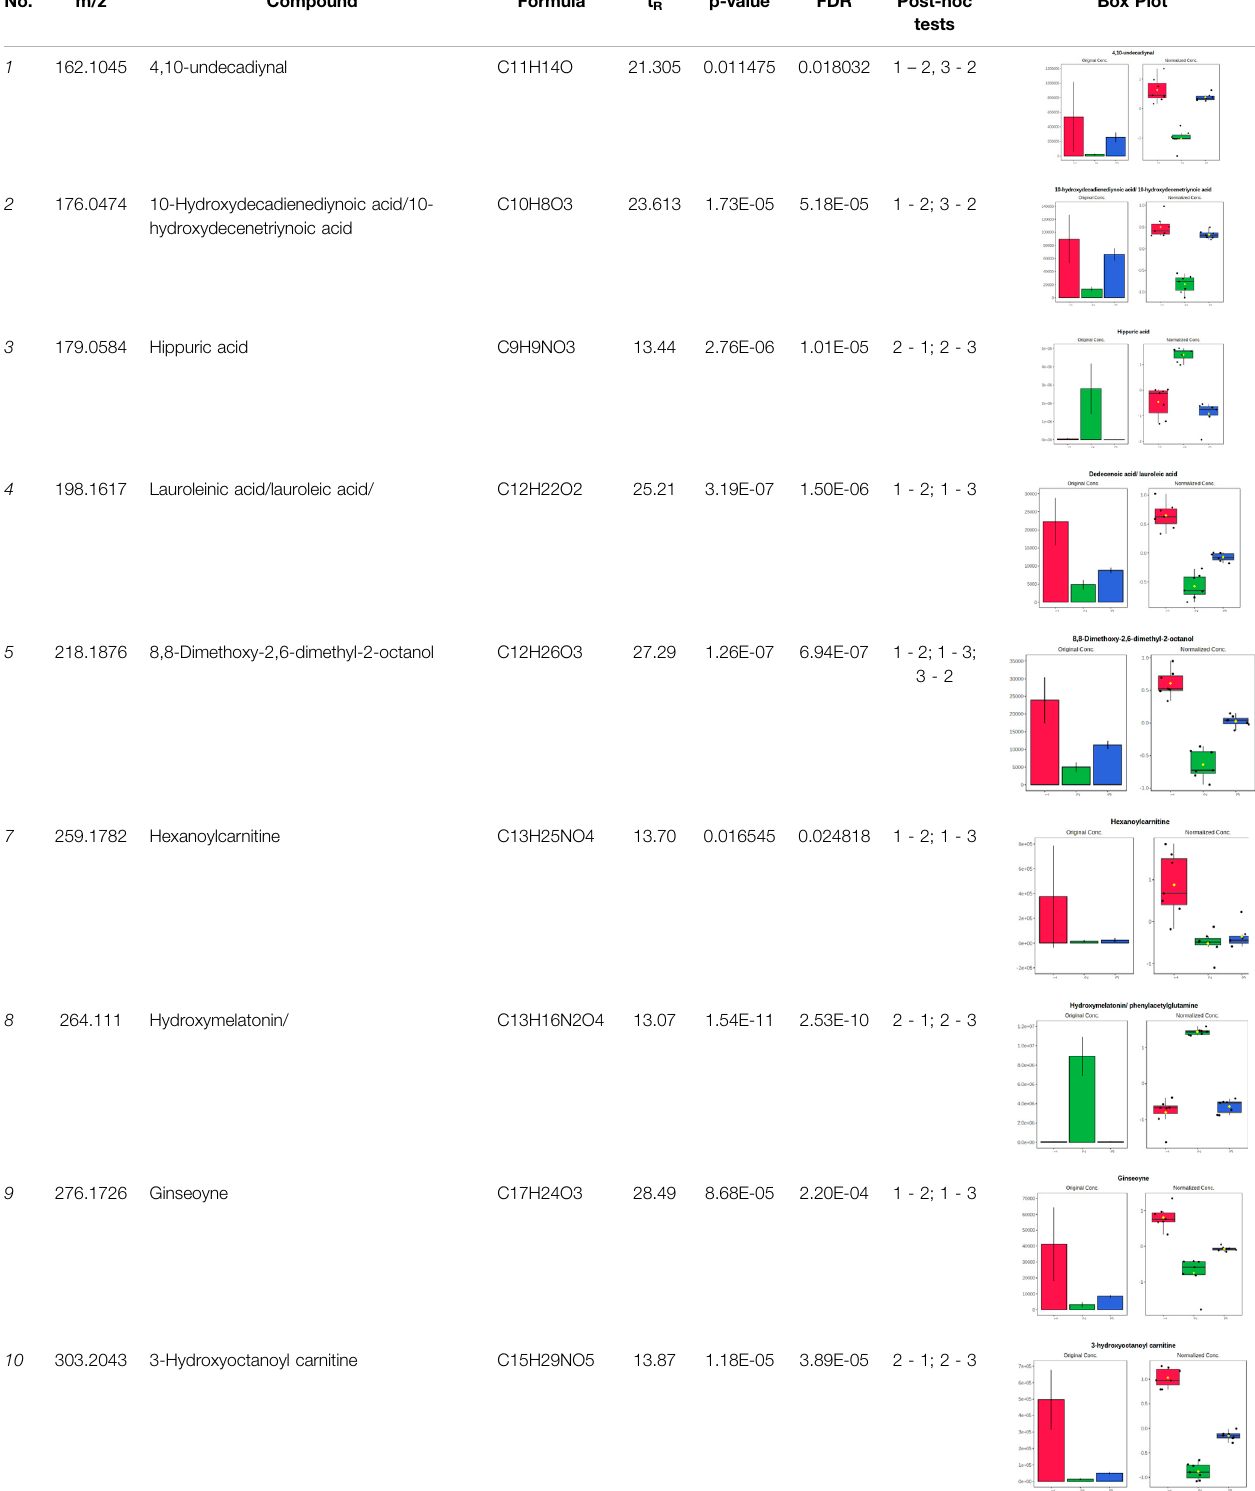
TABLE 3 | Statistically signi fi cant variables for all three tested matrices determined with the use of HPLC-TOF/MS.